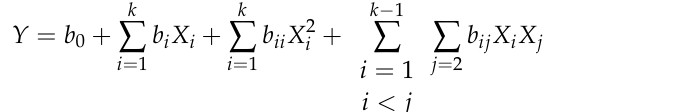
Table 5. Interpretation of coded levels of the three independent variables tested by RSM. Variables